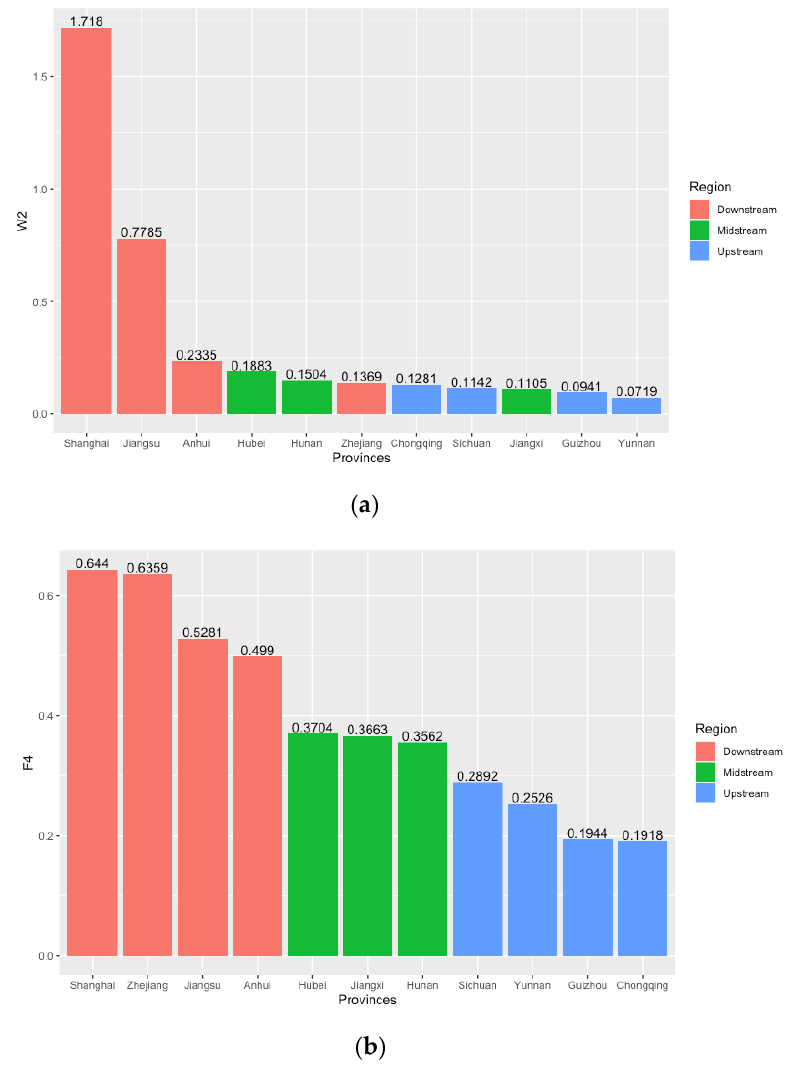
Figure 11. Comparison chart of key indicators of yellow pre-warning area: ( a ) comparison of water resources development and utilization rate (W2); ( b ) comparison of effective irrigation index (F4).